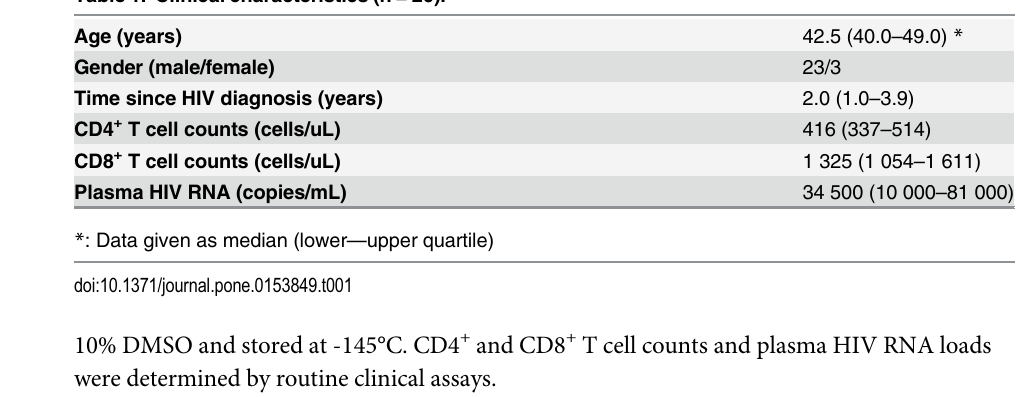
Table 1. Clinical characteristics (n =